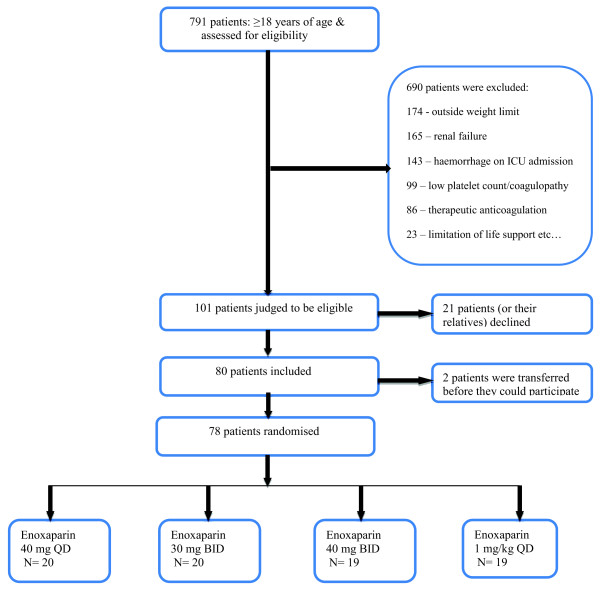
Consort diagram.